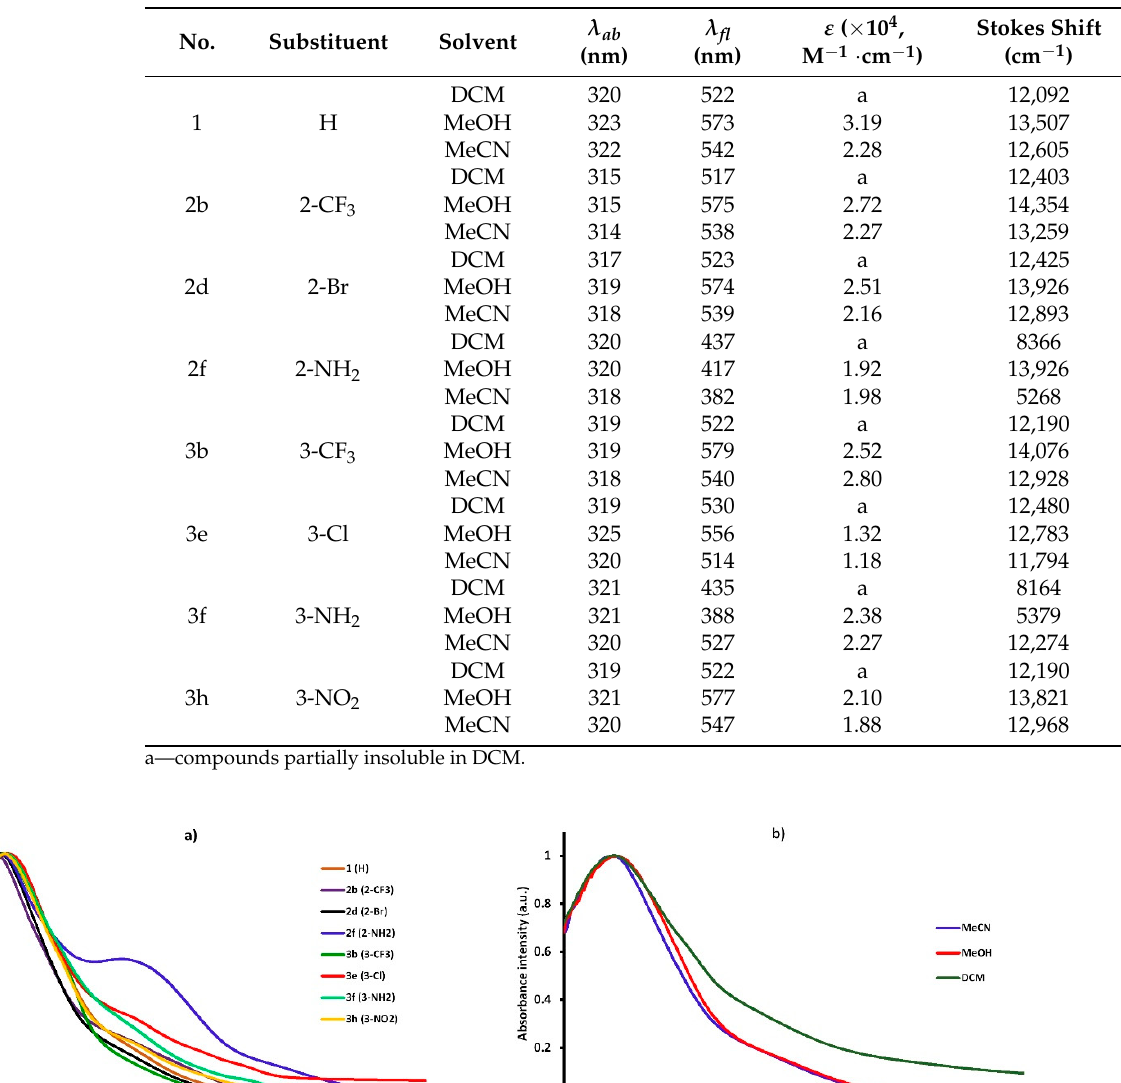
Table 8. Spectroscopic properties of the synthesized 5-nitroisatin-based benzoylhydrazines in solvents of different polarity.